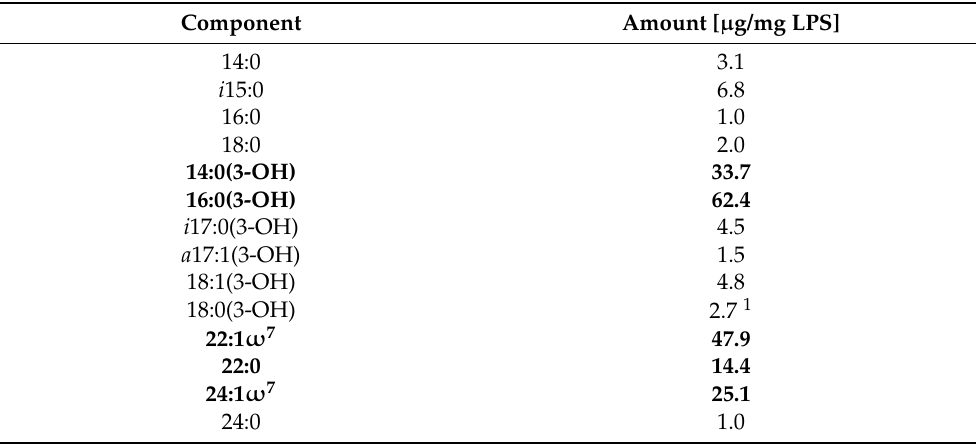
Table 1. Fatty acid composition of Rv LPS. For quantitative analysis, the LPS sample was hydrolyzed while using 4 M HCl. Main components are written in bold